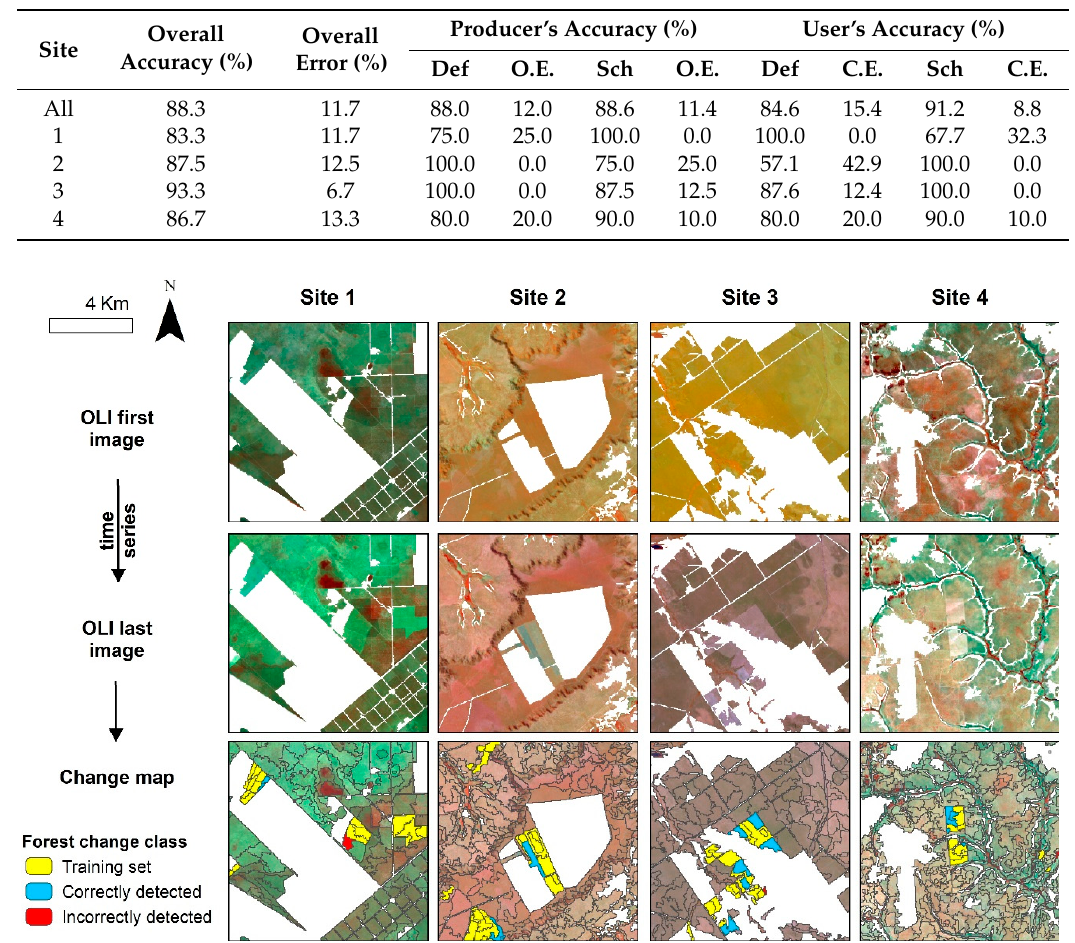
Figure 5. Change maps for the 2013–2014 period.